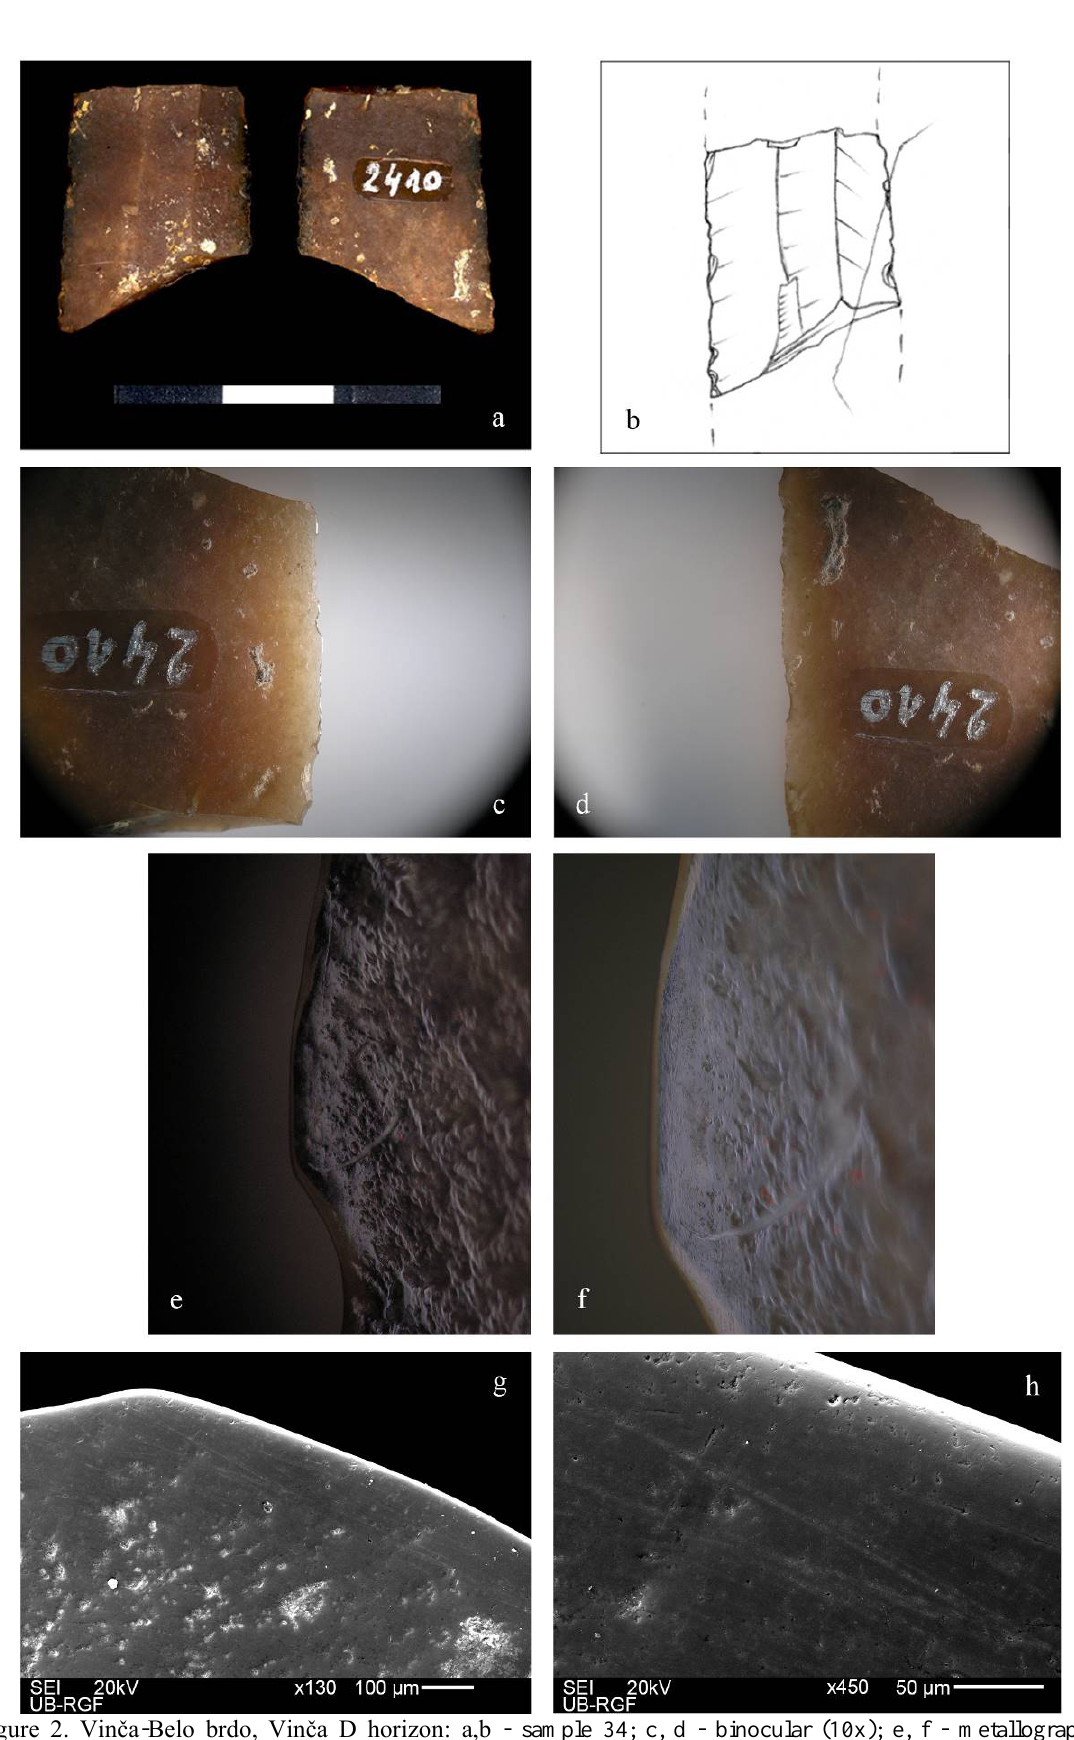
Figure 2. Vinča - Belo brdo, Vinča D horizon: a,b - sample 34; c, d - binocular (10x); e, f - metallographic microscope (70x); e - SEM (130x); f - SEM